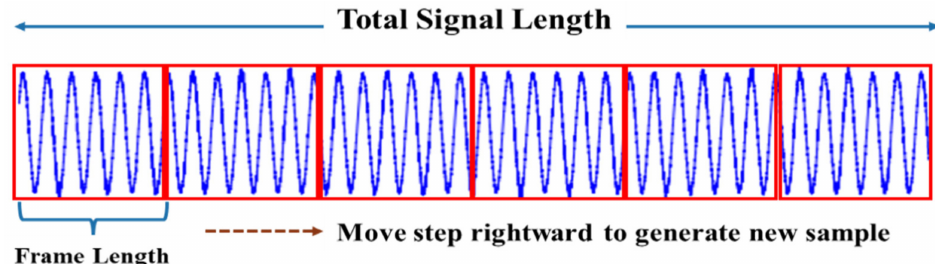
Figure 2. Data segmentation for converting time-series data into an